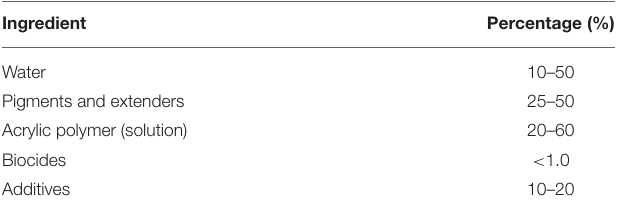
TABLE 1 | Composition of acrylic paints according to suppliers’ information.